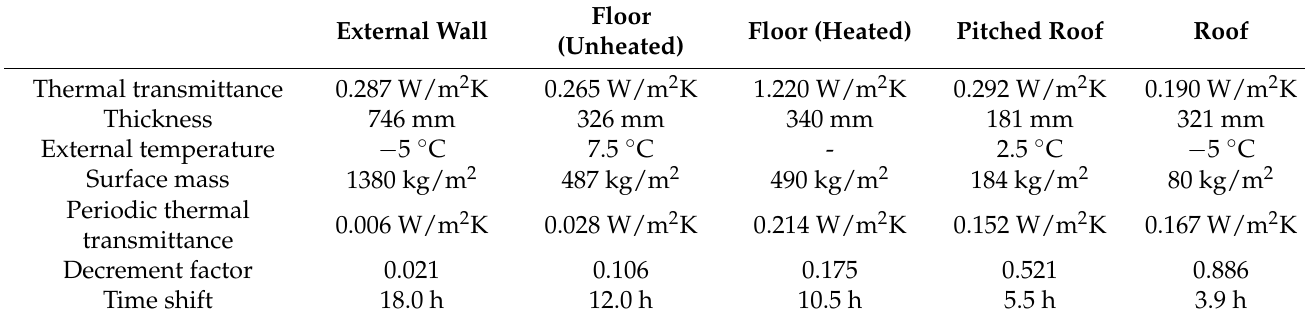
Table 8. Characteristics and main parameters of the opaque building envelope.